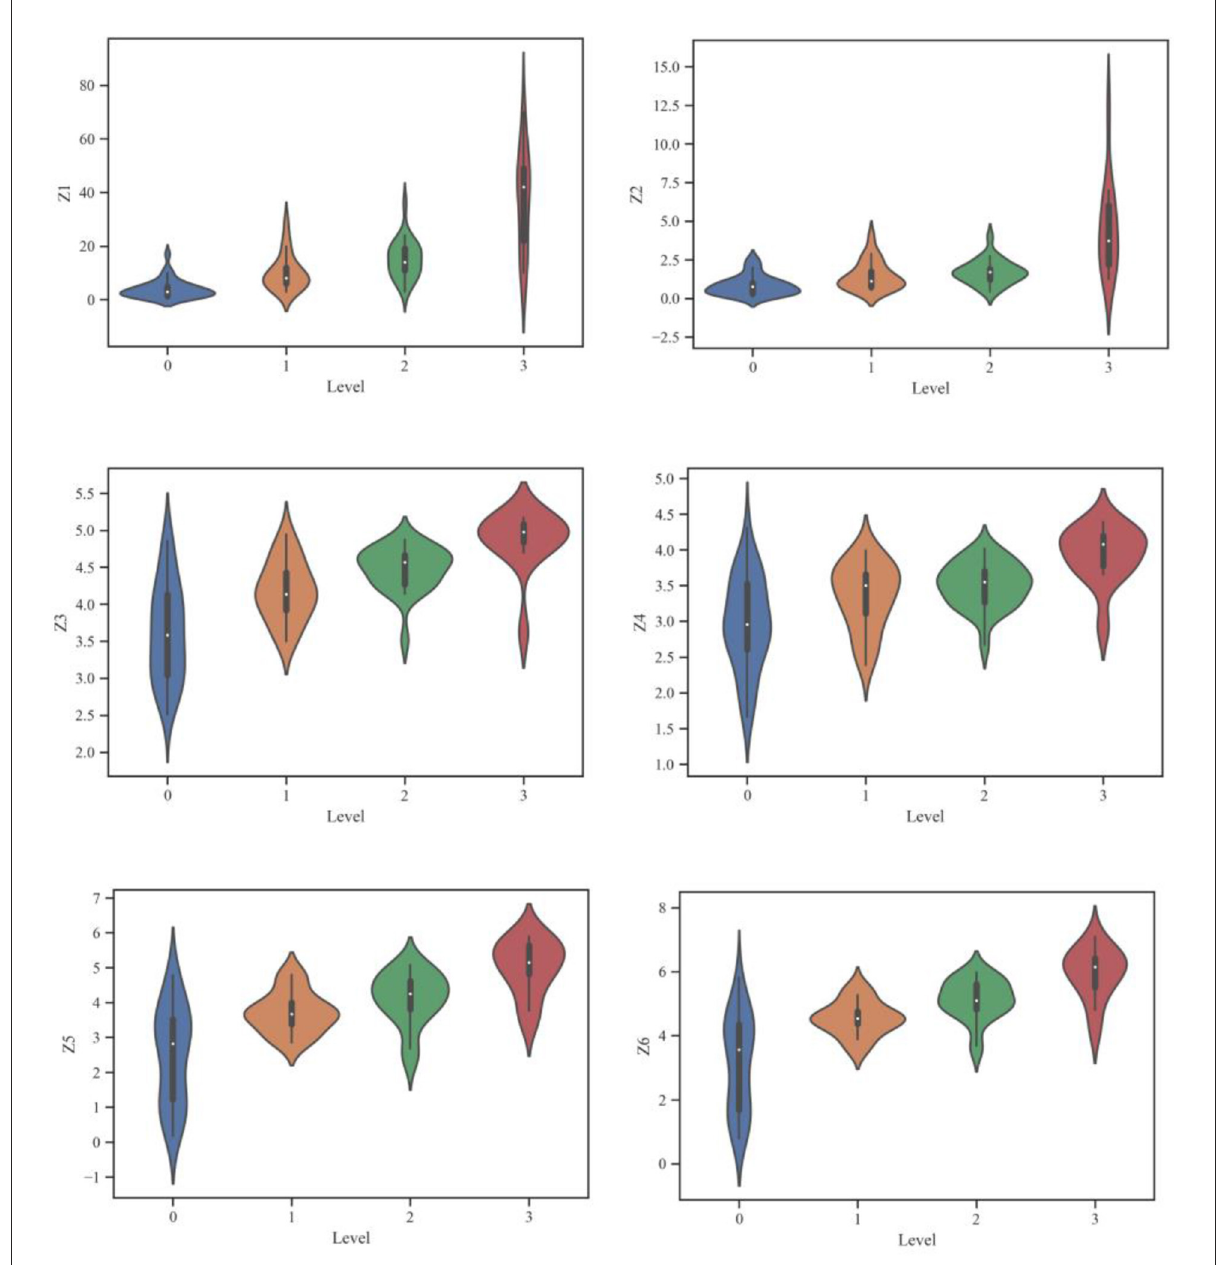
FIGURE3 Voilen chart of significant features employed in the